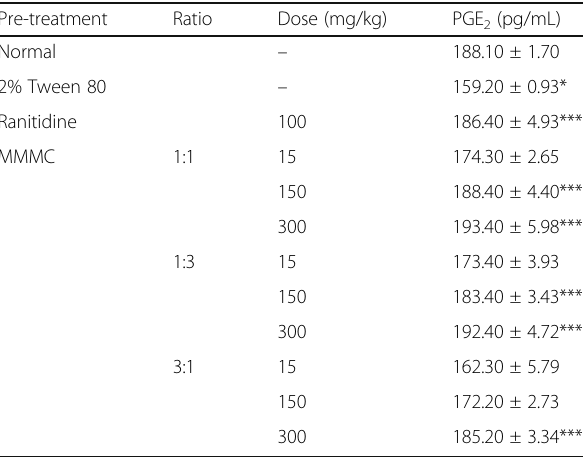
Table 4 Effect of MMMC on the PGE2 content in ethanol- induced gastric tissue of rats